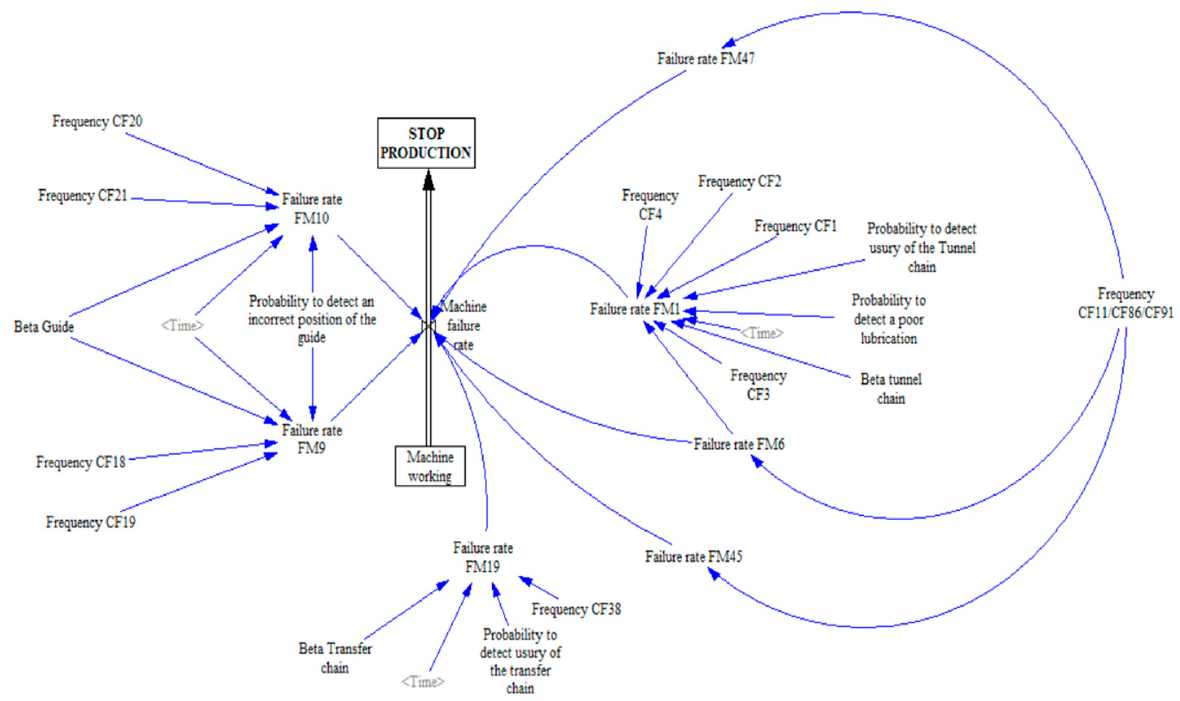
Figure 6. AS-IS model.